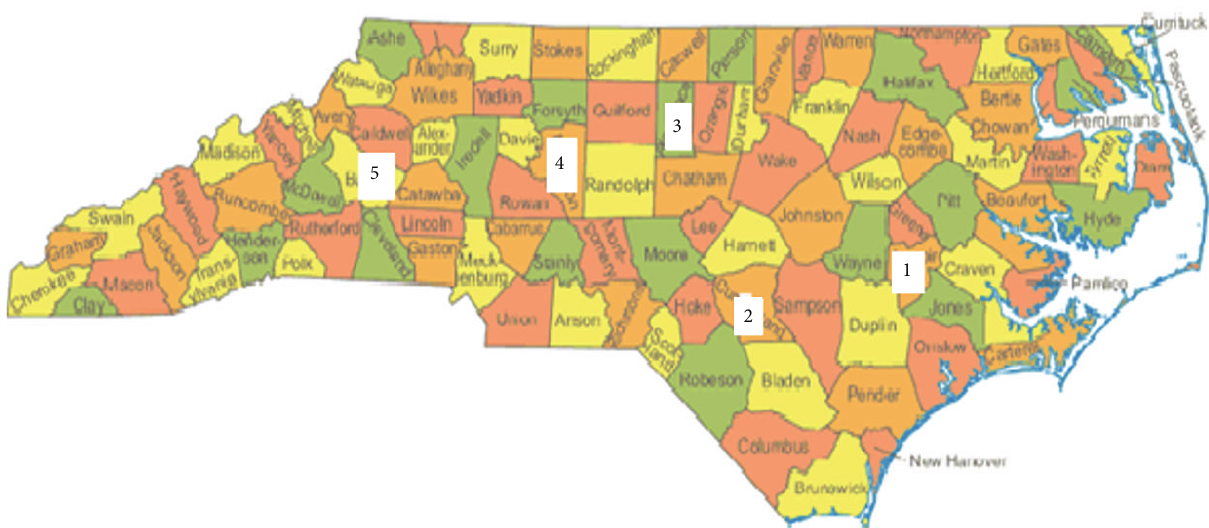
Figure 1: The geographic locations for the hospital network in North Carolina in the United States, problem set 1.